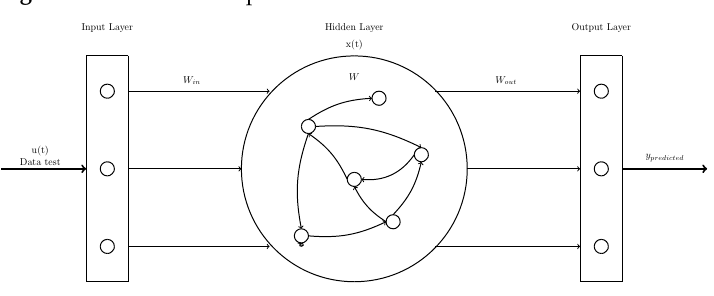
Figure 2. ESN closed-loop.